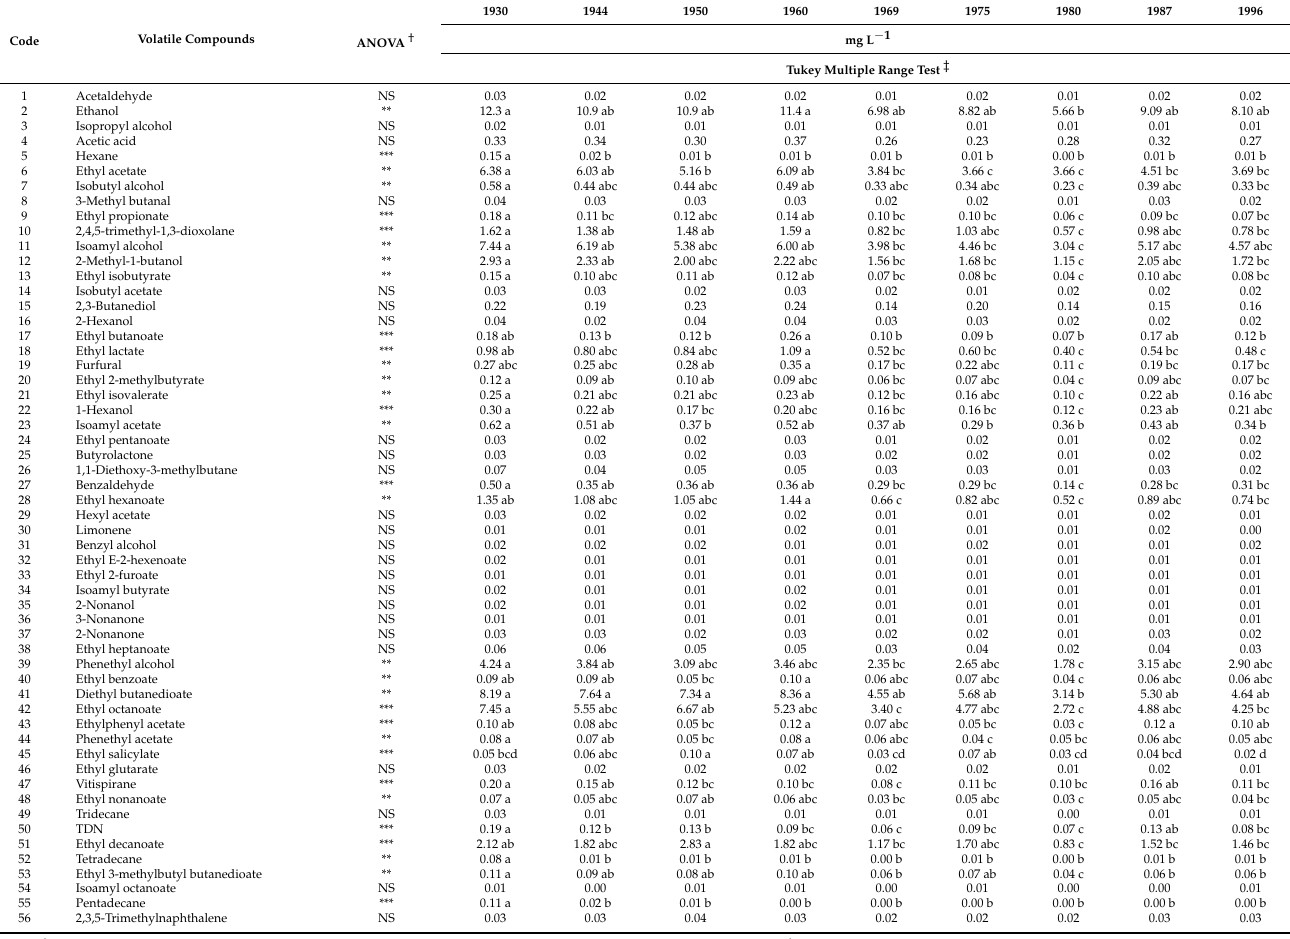
Table 3. Volatile compounds content (mg L − 1 ) of the Fondill ó n wines as affected by the “ solera ”